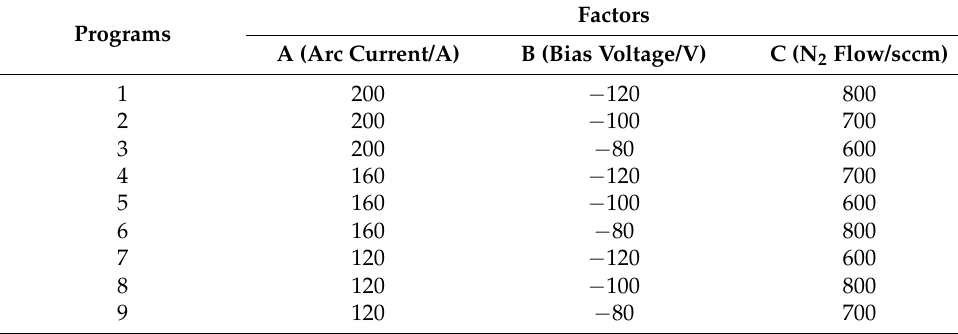
Table 2. Orthogonal experimental